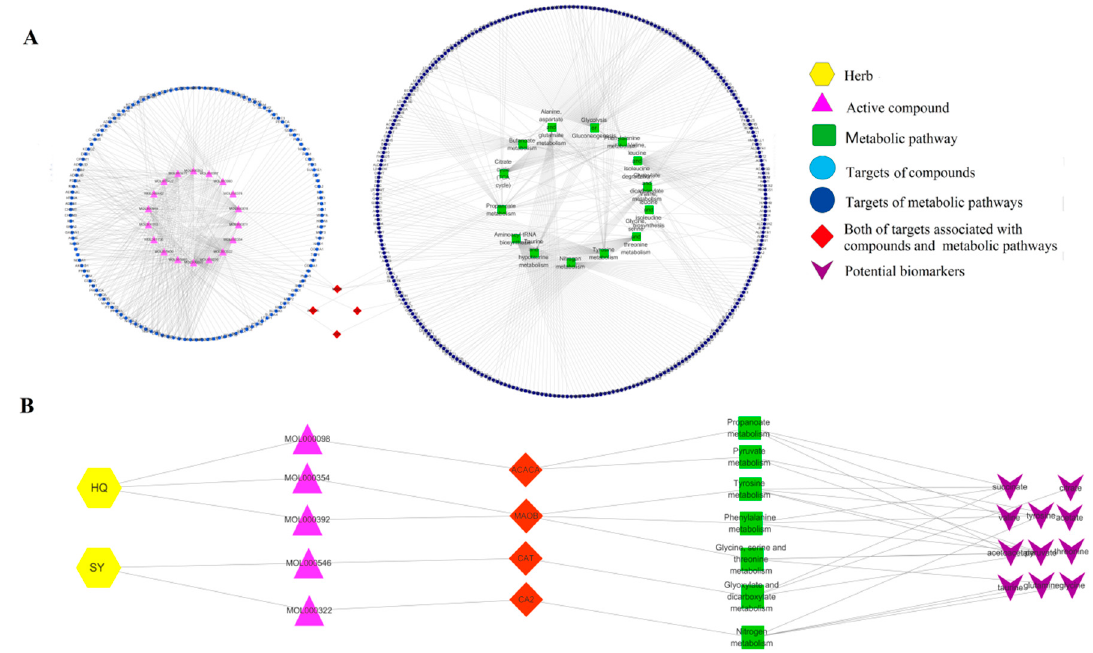
Figure7. ( A )Activecomponent–target–pathwayinteractionnetwork. ( B )Activecomponent–corresponding Figure 7. ( A ) Active component–target–pathway interaction network. ( B ) Active target–metabolic pathway–potential biomarker interaction network. The pink nodes represent the chemical component–corresponding target–metabolic pathway–potential biomarker interaction network. The components of HS, the azure nodes represent the predicted targets of component, the green nodes represent pink nodes represent the chemical components of HS, the azure nodes represent the predicted the metabolic pathway, and the mazarine nodes represent the target of pathway. The red nodes represent targets of component, the green nodes represent the metabolic pathway, and the mazarine nodes both of targets associated with component and metabolic pathway. The purple nodes represent related represent the target of pathway. The red nodes represent both of targets associated with component potential and metabolic pathway. The purple nodes represent related potential biomarker.